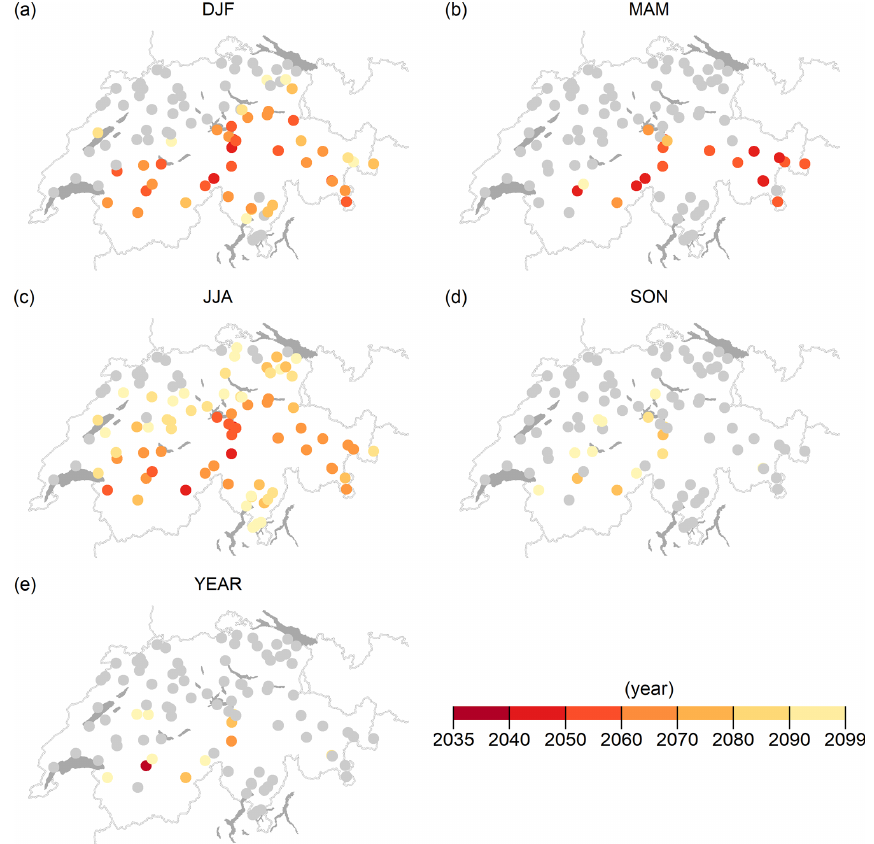
Figure 6. Time of emergence for winter (a) , spring (b) , summer (c) , autumn (d) , and year (e) when at least 66% of the models agree on significant changes in the distribution of seasonal and annual